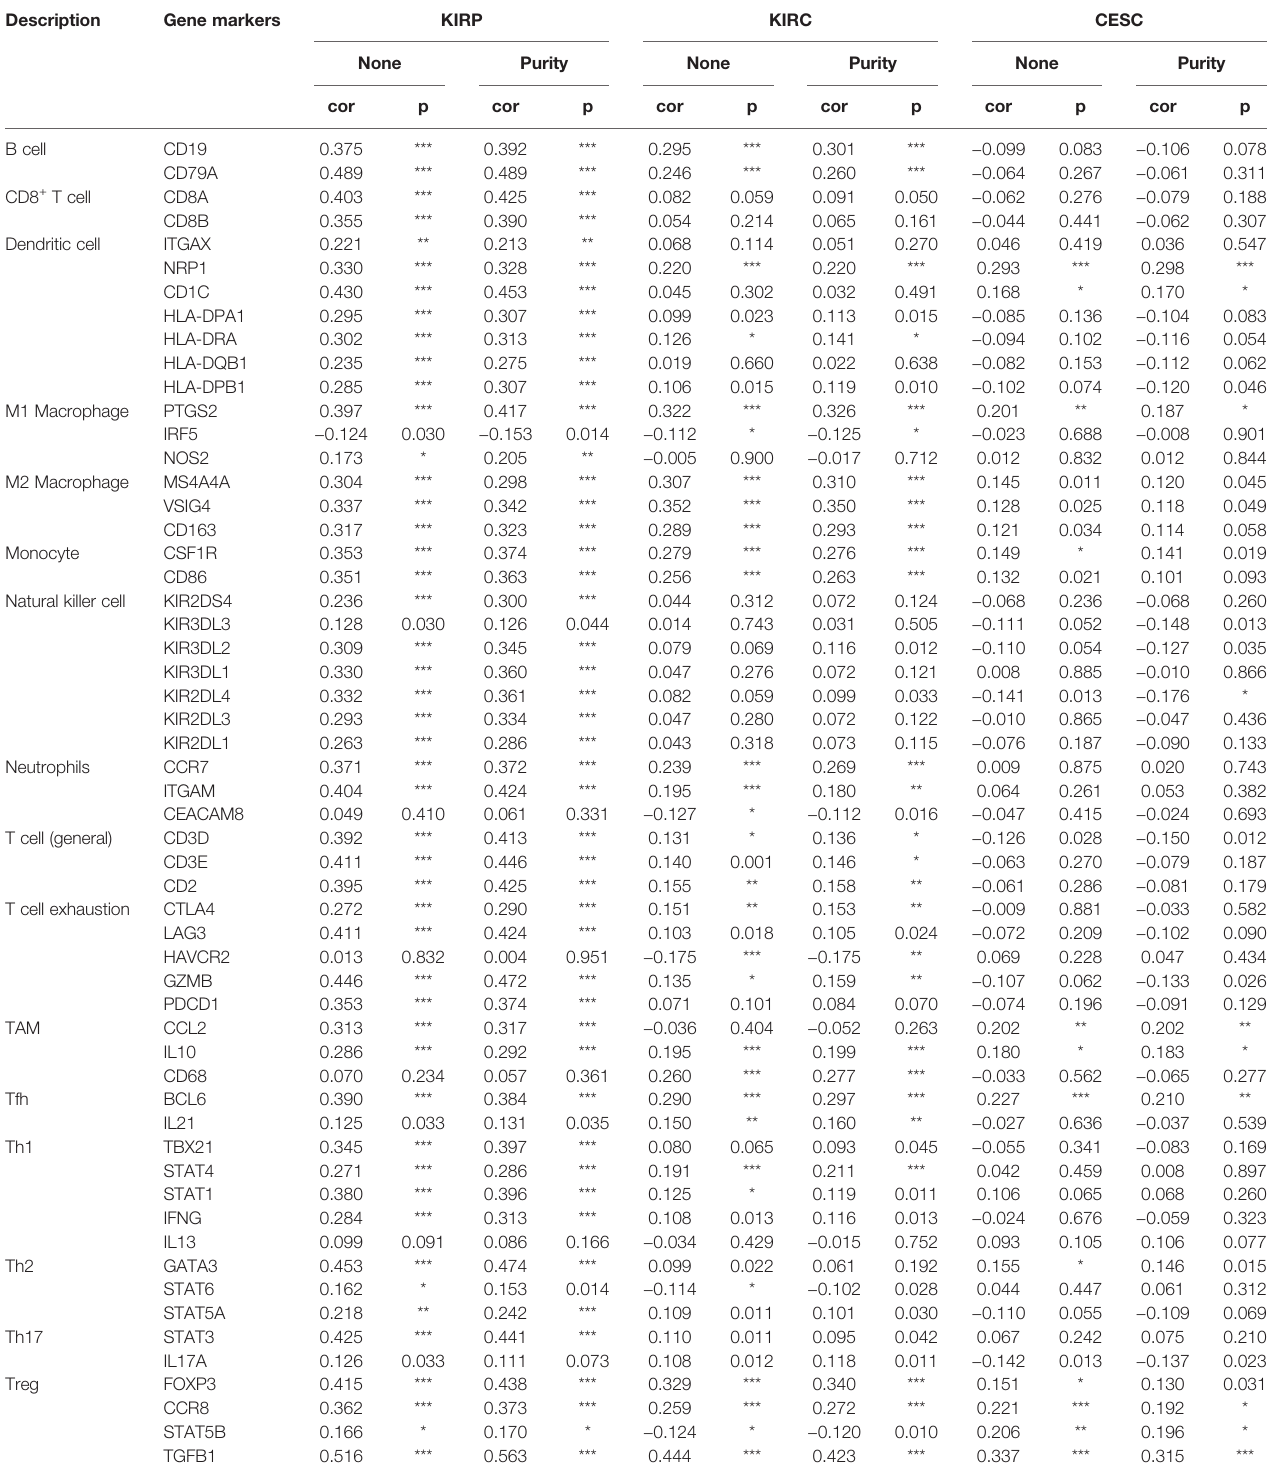
TABLE 4 | Correlation analysis between CTHRC1 and relate genes and markers of immune cells in TIMER. Description Gene